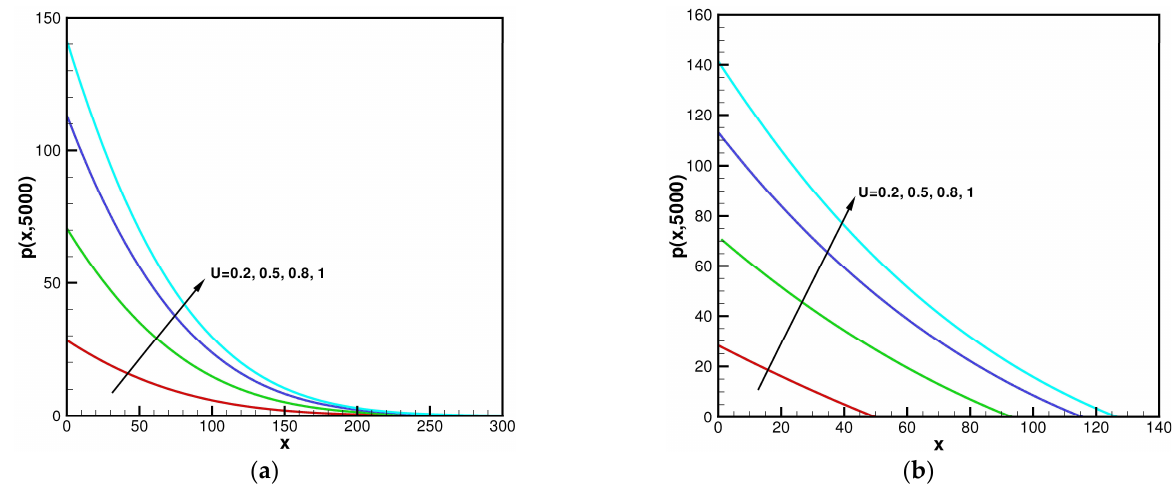
Figure 5. The distribution of non-dimensional formation pressure p ( x , t ) : ( a ) Comparison of the distributions of non-dimensional formation pressure depending on different values of U when λ = 0, t = 5000; ( b ) Comparison of the distributions of non-dimensional formation pressure depend- ing on different values of U when λ = 0.5, t = 5000.